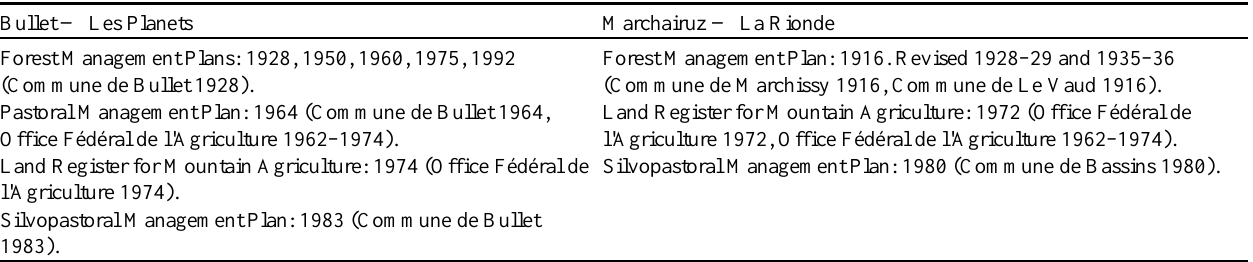
Table 1 . List of the documents consulted for the project. Bullet — Les